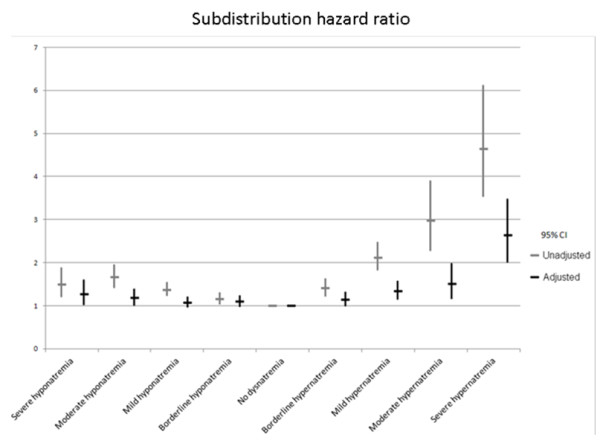
Relationship between hospital admission serum sodium concentrations and day-30 mortality. Subdistribution hazard ratio (sHR) and 95% confidence interval (95% CI) are represented before (light grey) and after adjustment for confounders (dark).